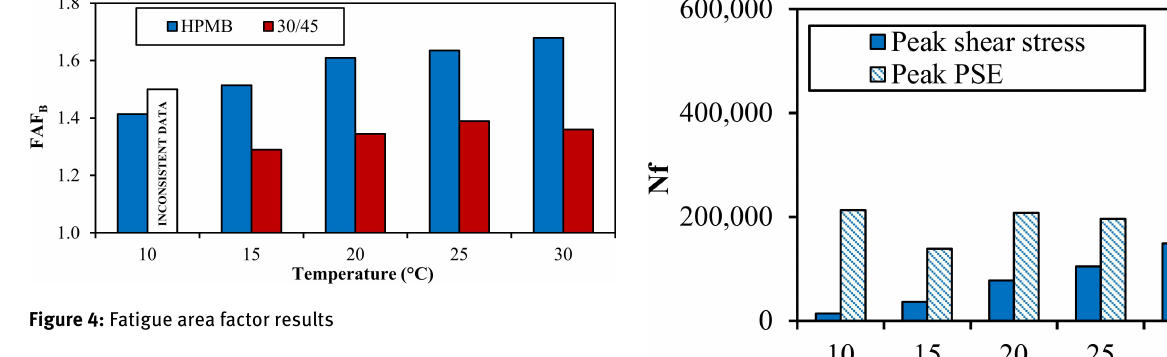
failure mechanism of fatigue cracking in asphalt binders.